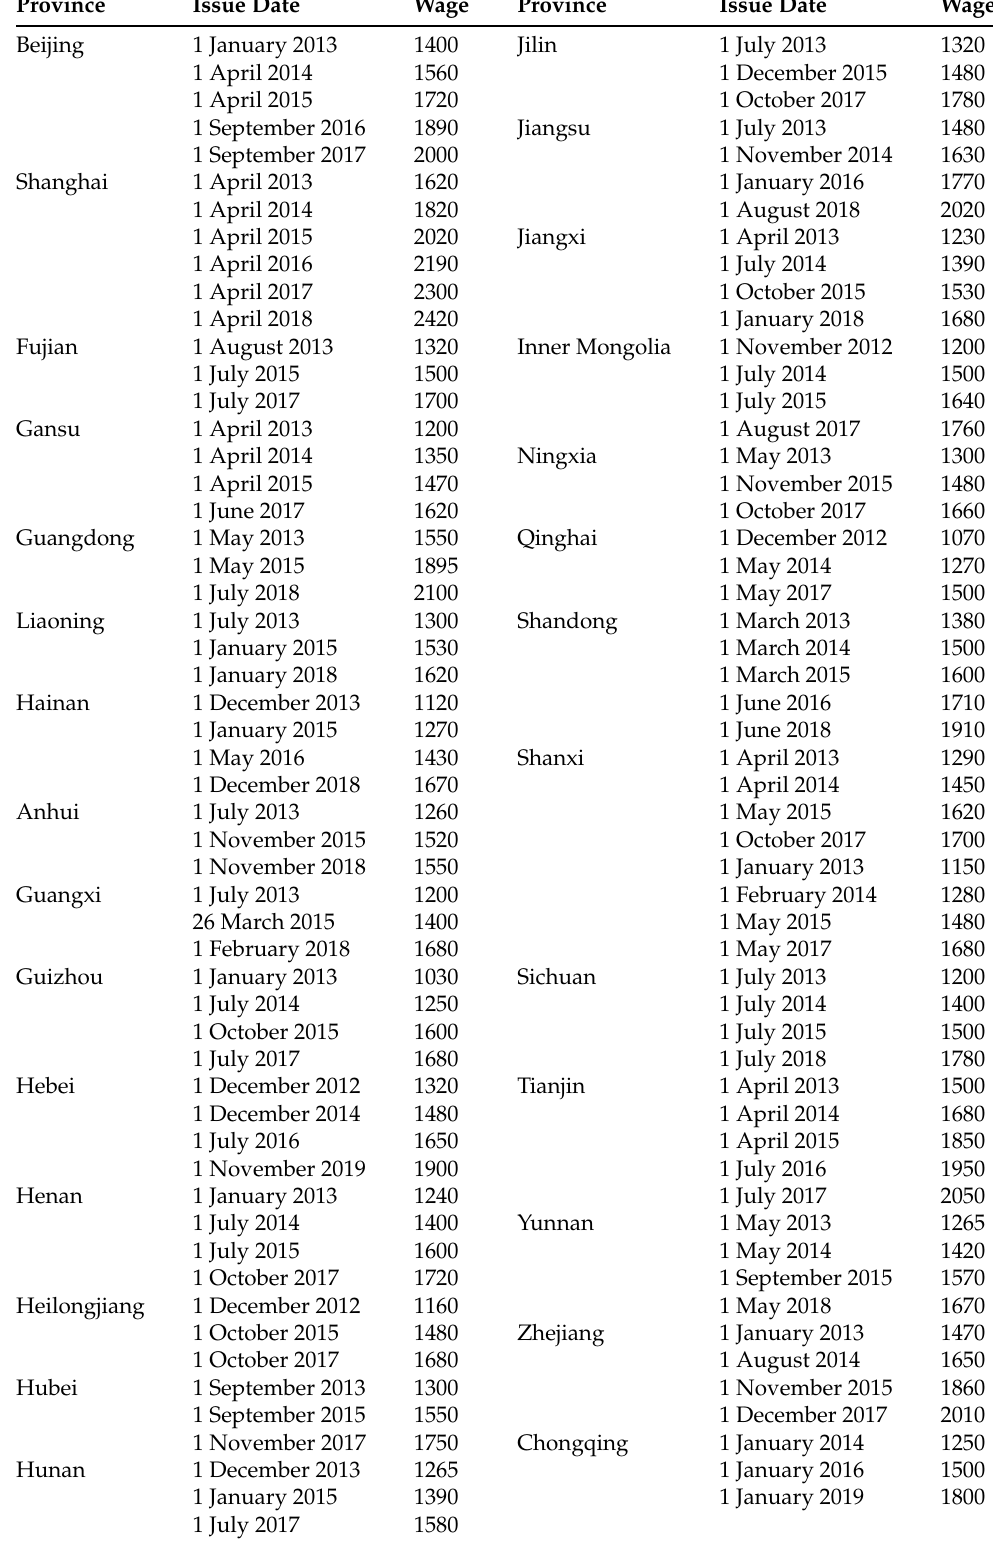
Table 2. Minimum wage changes across Chinese provinces: Issue dates (year.month.day) and (current value) nominal wages (in